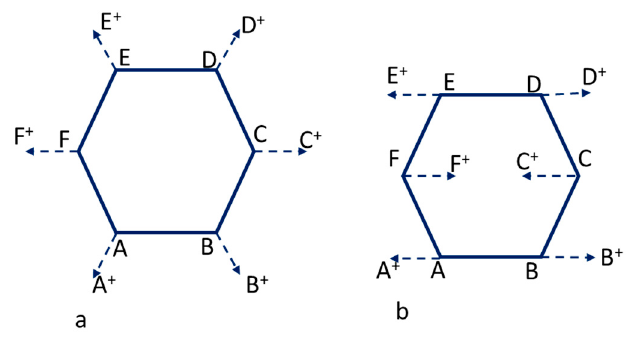
Figure 3. Scheme of the vibration modes: ( a ) Breathing mode A 1g (D-peak) and ( b ) Vibration mode E 2g (G-peak).